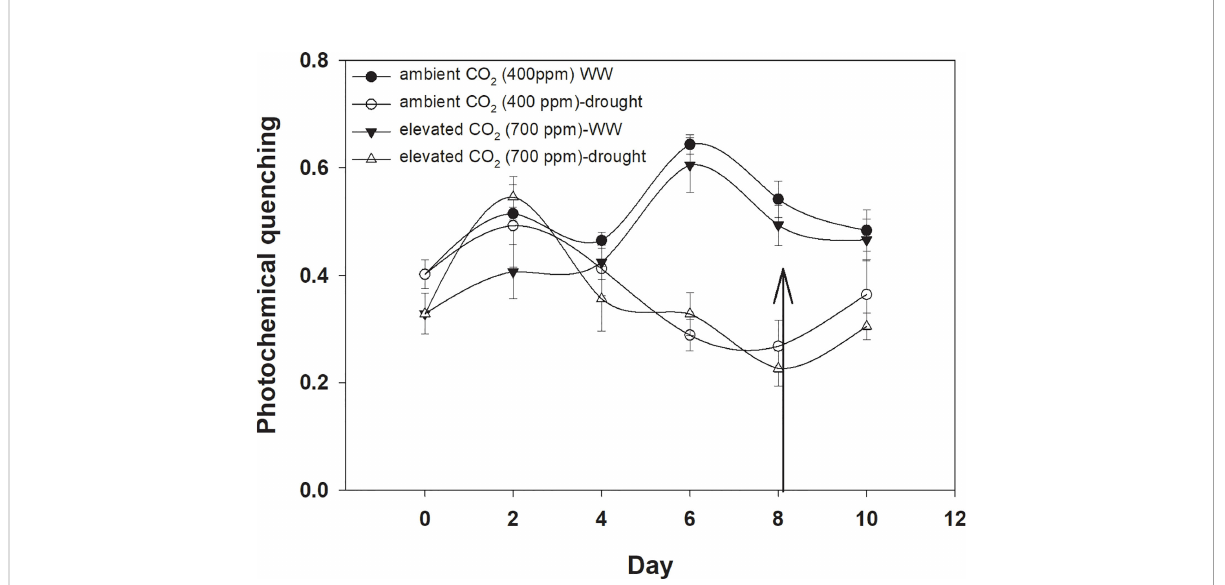
FIGURE 8 Effect of CO 2 concentrations and moisture conditions on photochemical quenching of Datura stramonium . A nail on the data point represents the standard error of the mean and the vertical arrow line after Day 8 represents the addition of water in the drought treatments. WW,